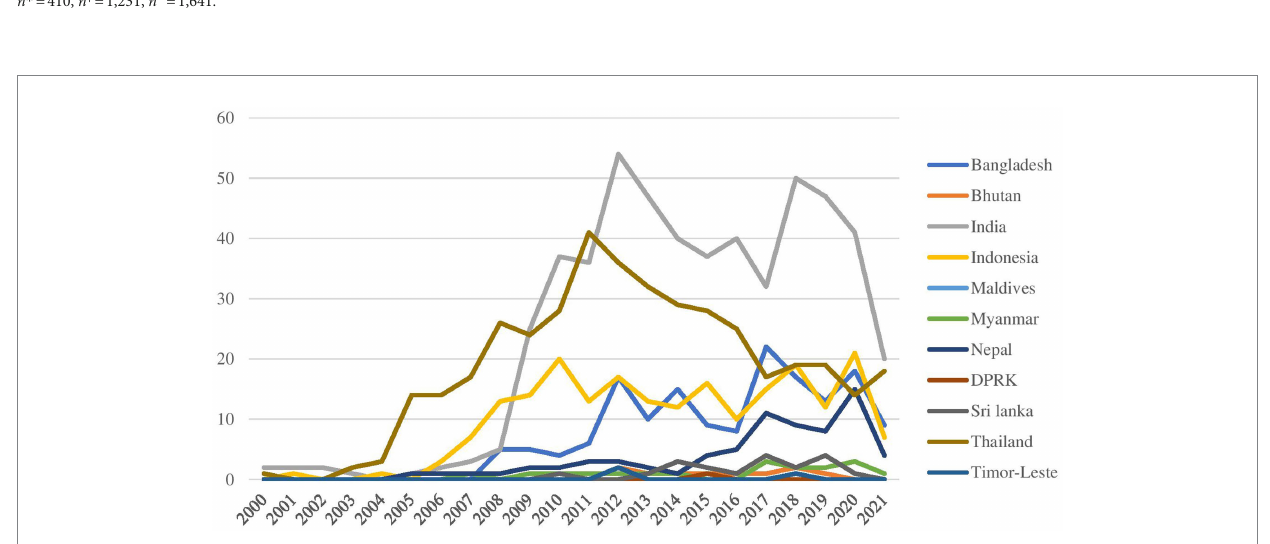
FIGURE 1 Trend in the number of publications from SEAR member states,